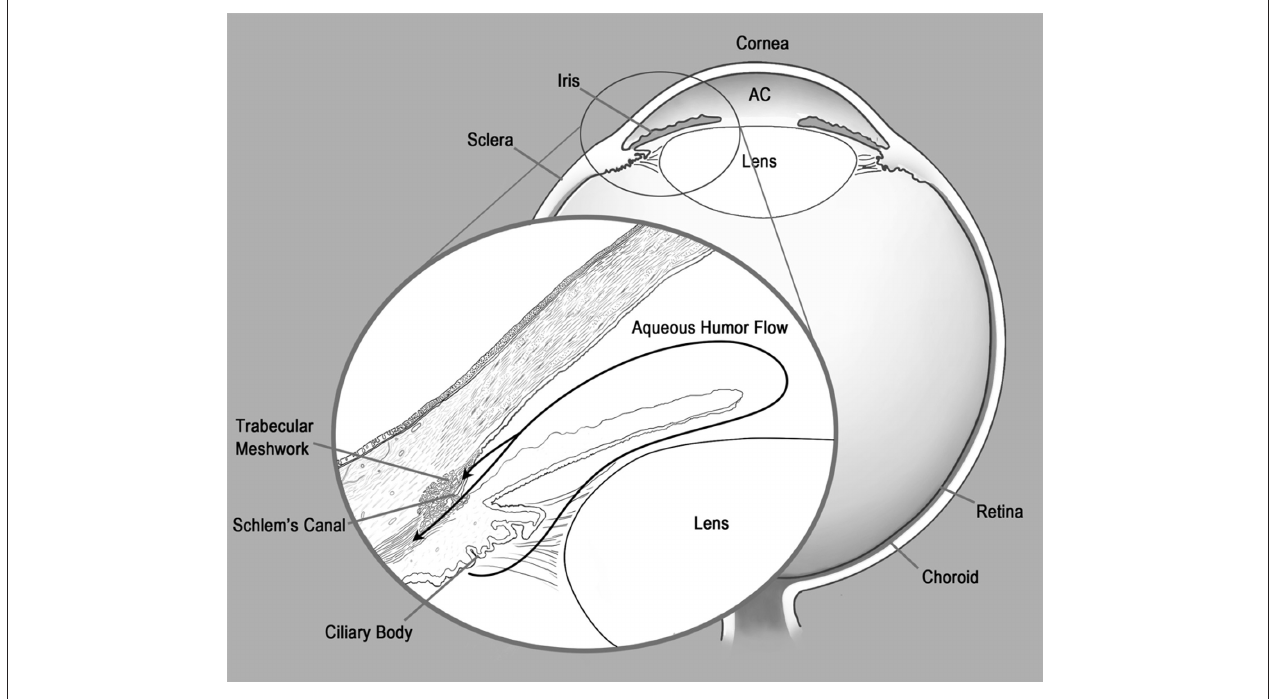
FIGURE 1 | Ocular anatomy and drainage. Anterior chamber